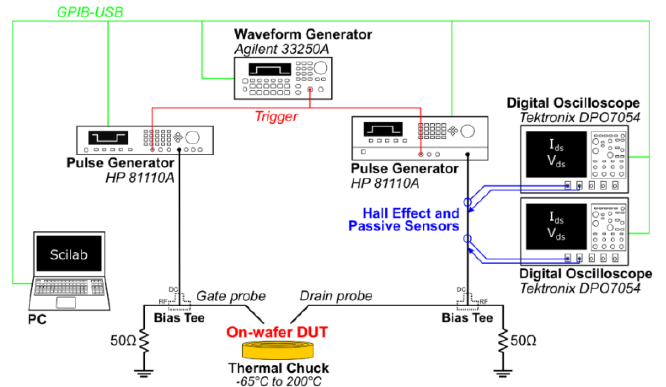
Figure 1. Drain current transient (DCT) spectroscopy measurement setup for AlGaN/GaN HEMT.